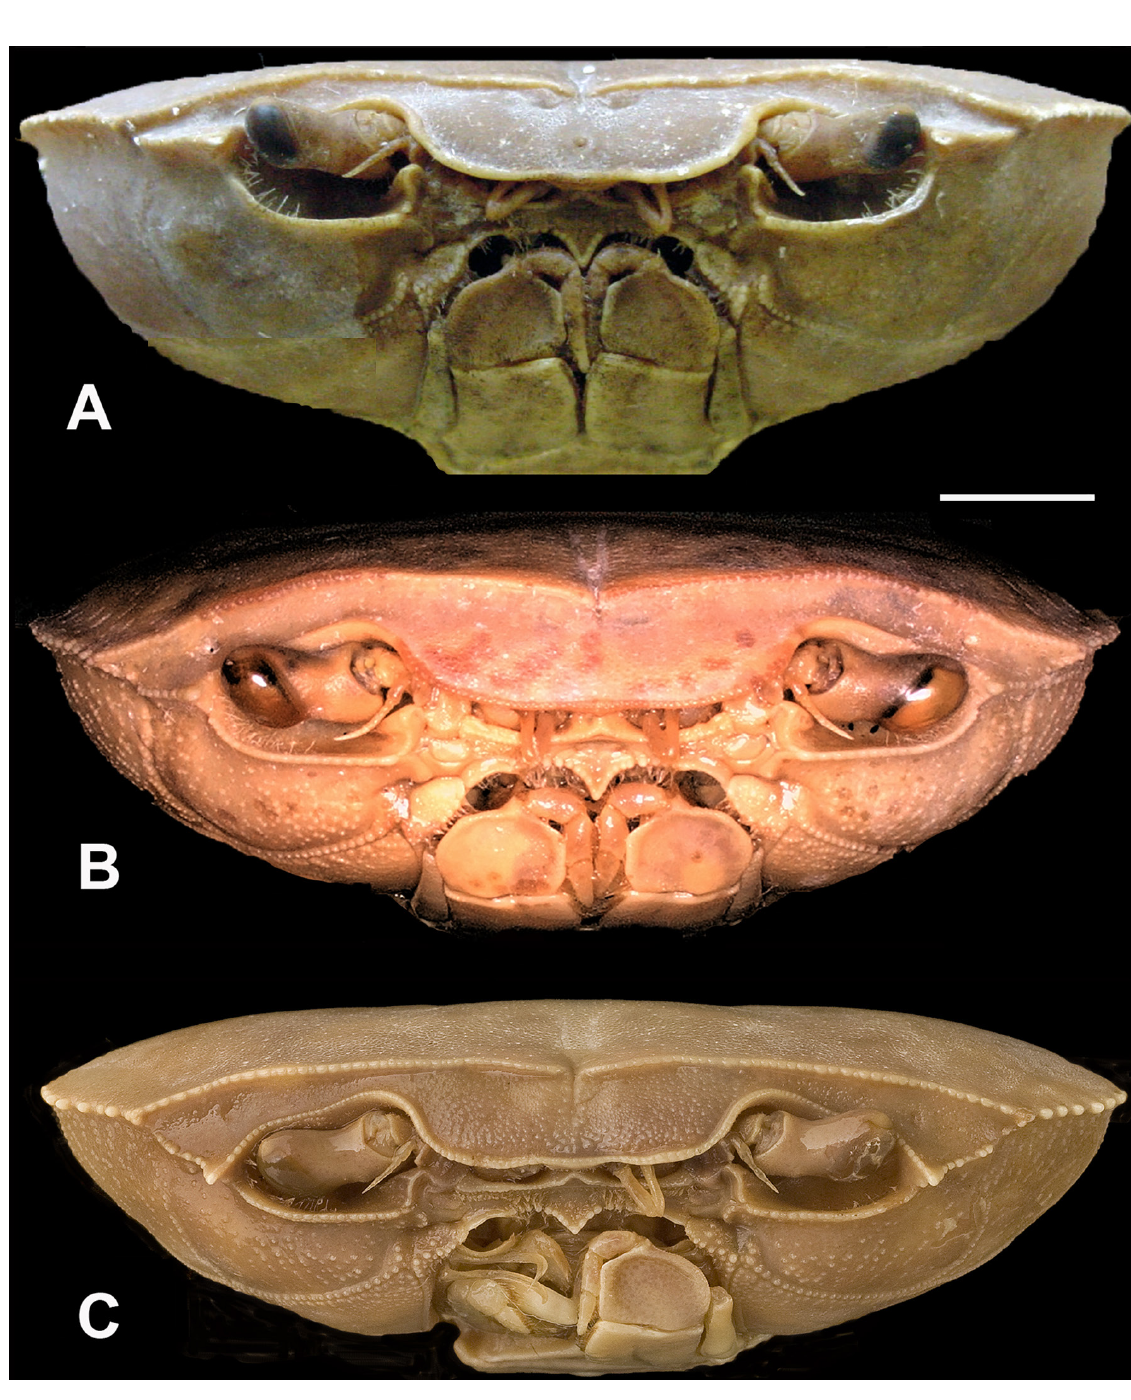
Fig. 5. Frontal view of carapace. A . Potamonautes kisangani sp. nov., holotype, adult, ♂, CW 60.5 mm, from Kisangani, Democratic Republic of the Congo (USNM 98944). B . P. amosae sp. nov., holotype, adult, ♂, CW 46.5 mm, from Lake Kivu, D.R. Congo (NHMUK 2018.306). C . P. orbitospinus (Cunnington, 1907), lectotype, adult, ♂, CW 56.9 mm, from Nkhata Bay, Lake Malawi, Malawi (NHMUK 1908.1.31.27). Scale bar: A = 8.5 mm; B = 6.3 mm; C = 7.8 mm. Photograph C by Phillip Crabb,